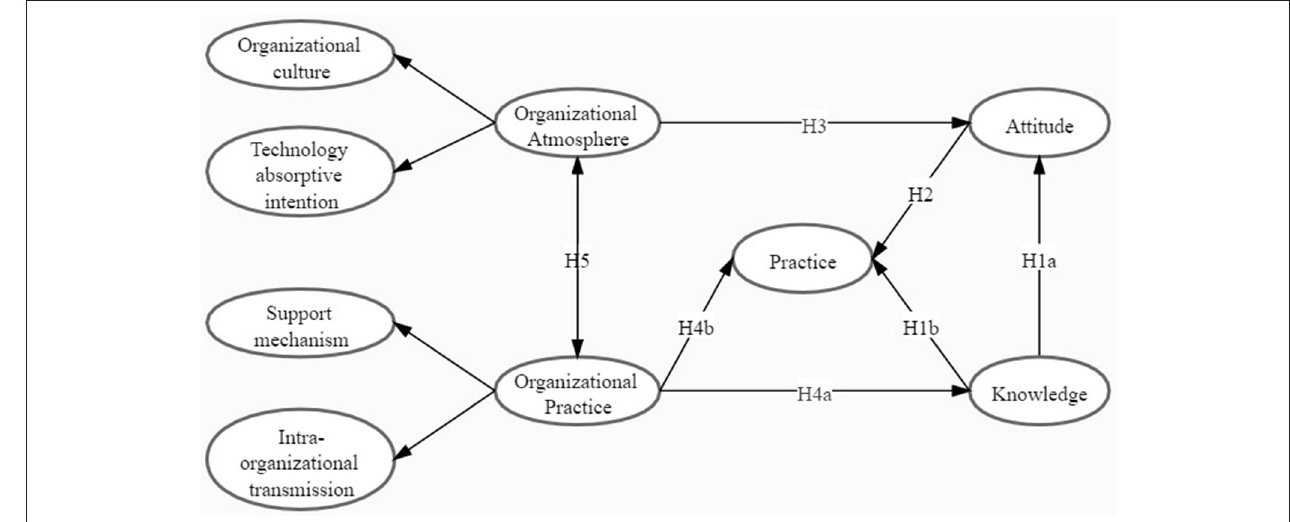
FIGURE 1 | The theoretical